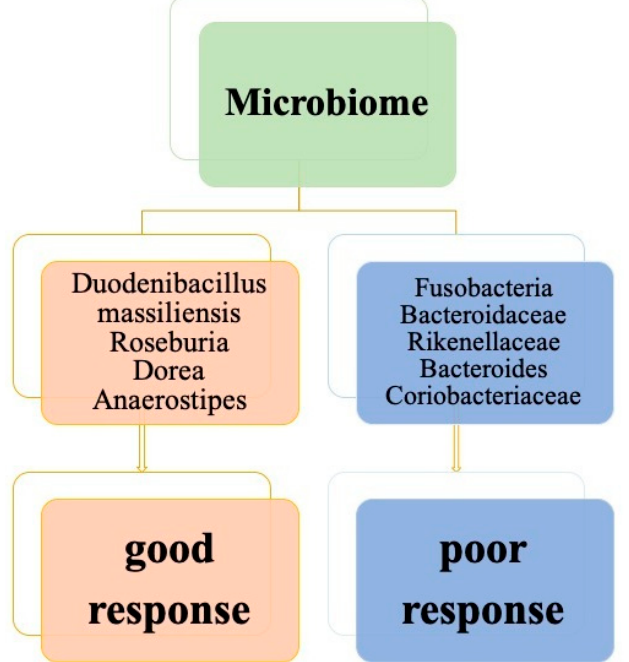
Figure 3. The different species of microbiota between favorable and unfavorable responses from neoadjuvant concurrent chemoradiation in patients with locally advanced rectal cancer.